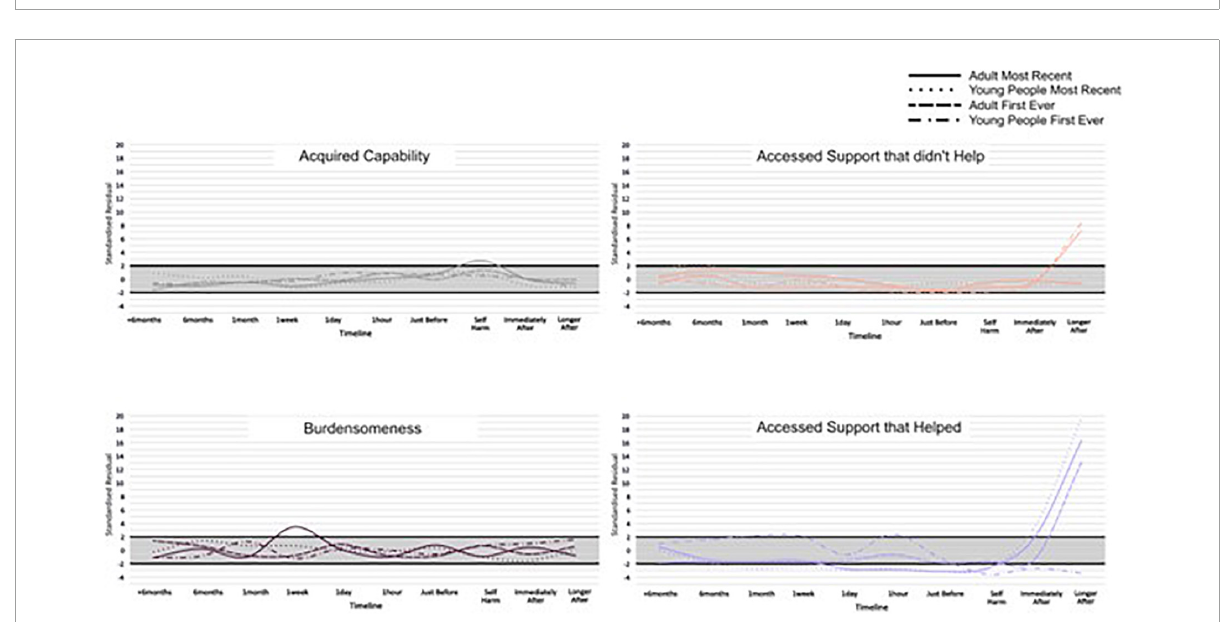
FIGURE7 Indicator Wave graphs comparing the standardised residuals (SRs) for each group across the timeline, for the categories: Acquired capability, burdensomeness, accessed support that didn’t help, and accessed support that